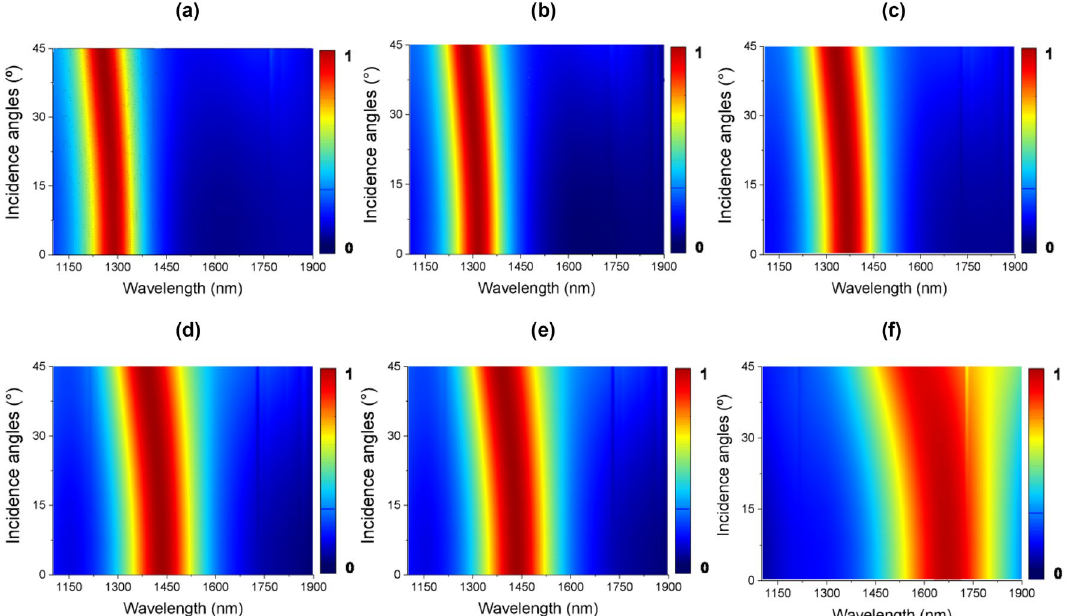
Figure 5. Dependence of the absorption for incident angles from 0° to 45° in TE polarization in the 1100– 1900 nm spectrum on: ( a ) amorphous phase ( m = 0%), ( b ) m = 20%, ( c ) m = 40%, ( d ) m = 60%, ( e ) m = 80%, and ( f ) crystalline phase ( m = 100%).